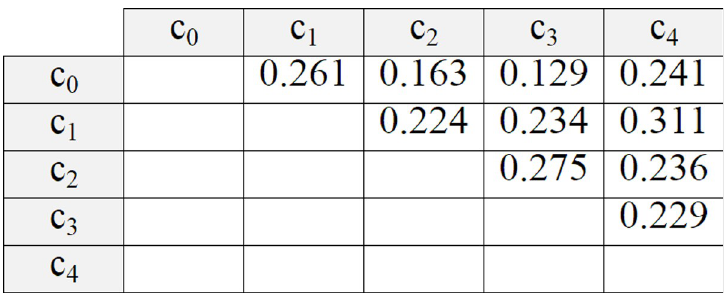
Fig 10. Distance between centroids to calculate the ADBC value.